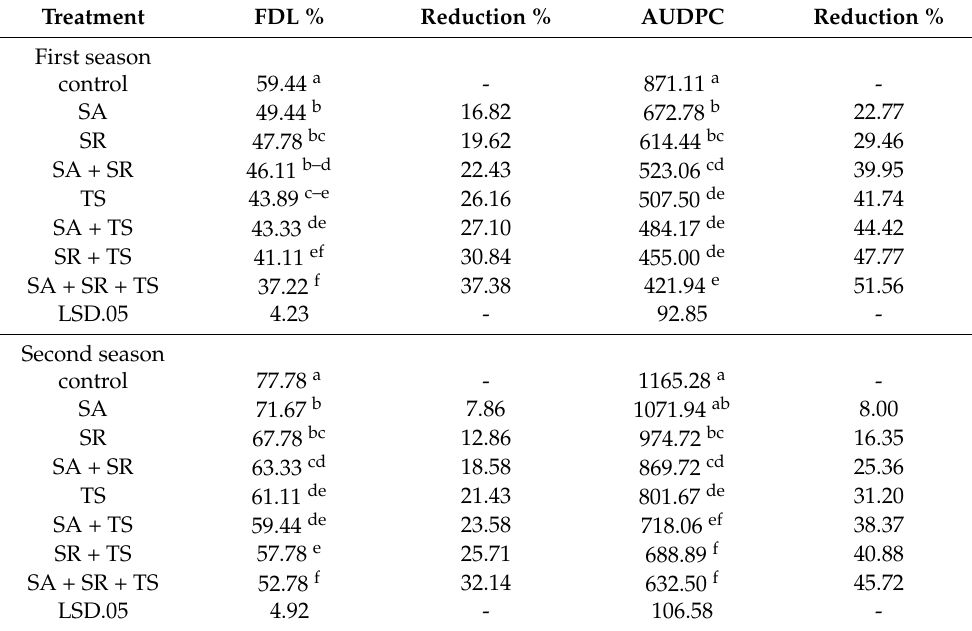
Table 4. Effect of 40 ppm shikimic acid (SA) seed priming and foliar applications of bioagents on the final powdery mildew disease severity level (FDL%) and the area under the disease progress curve